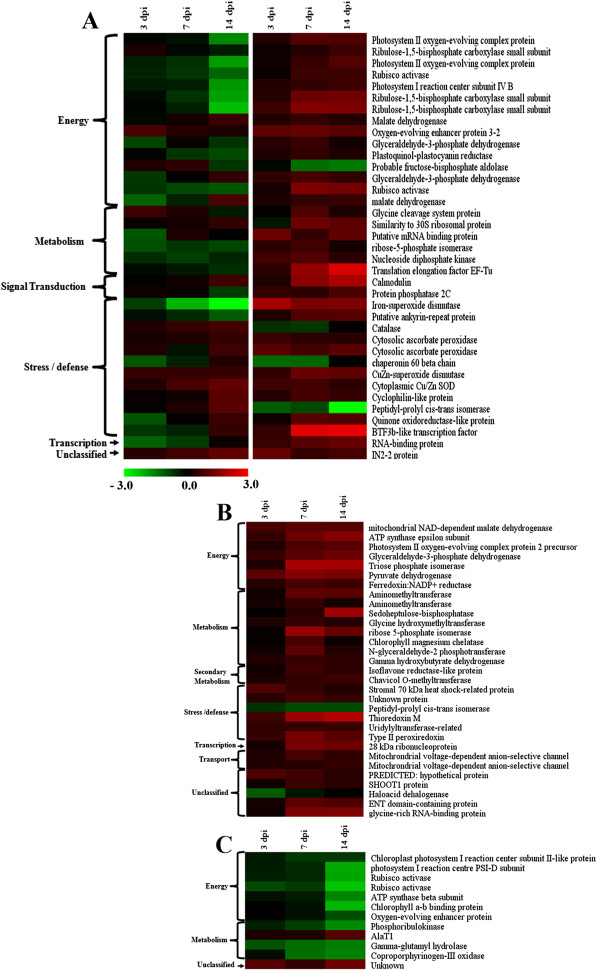
Heat map profile of differentially abundant proteins on compatible and incompatible interaction between MYMIV and V. mungo leaf proteome. Between compatible and incompatible interactions (A); only during incompatible interaction (B); only during compatible interaction (C). Protein abundance ratios (log 2 base transformed) are color coded with red indicating increased in abundance by MYMIV infection; green indicating decrease in abundance by the virus infection; and black indicating no change. Protein lists were clustered according to their functional category.